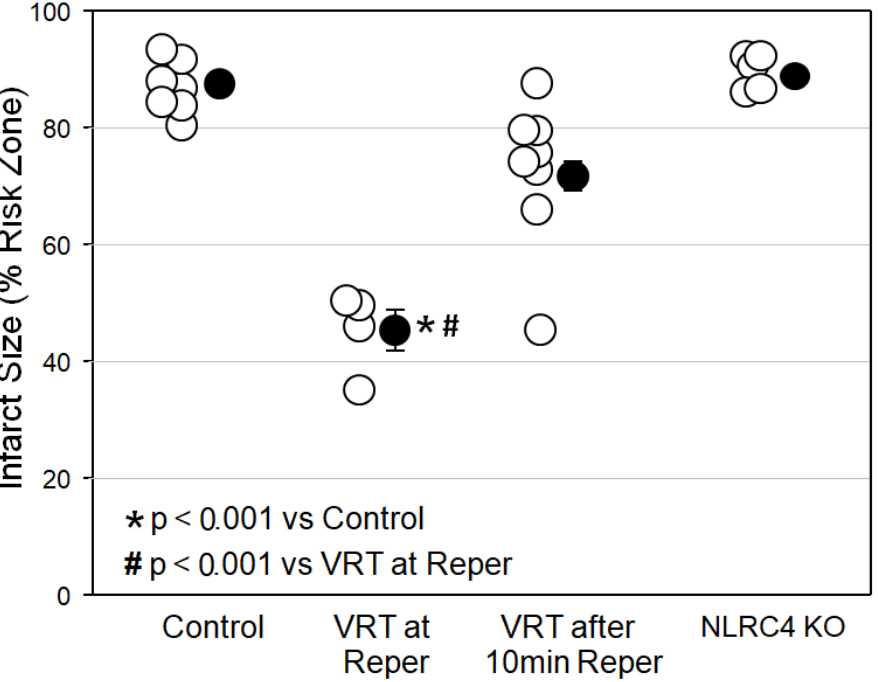
Figure 2. Infarct size as a percentage of the risk zone in isolated male wild-type and NLRC4-KO mouse hearts undergoing 50 min global ischemia/2 h reperfusion. Open circles represent individual hearts, and solid circles represent means ± SEM. Abbreviations: KO, knockout; Reper, reperfusion; VRT, VRT-043198.